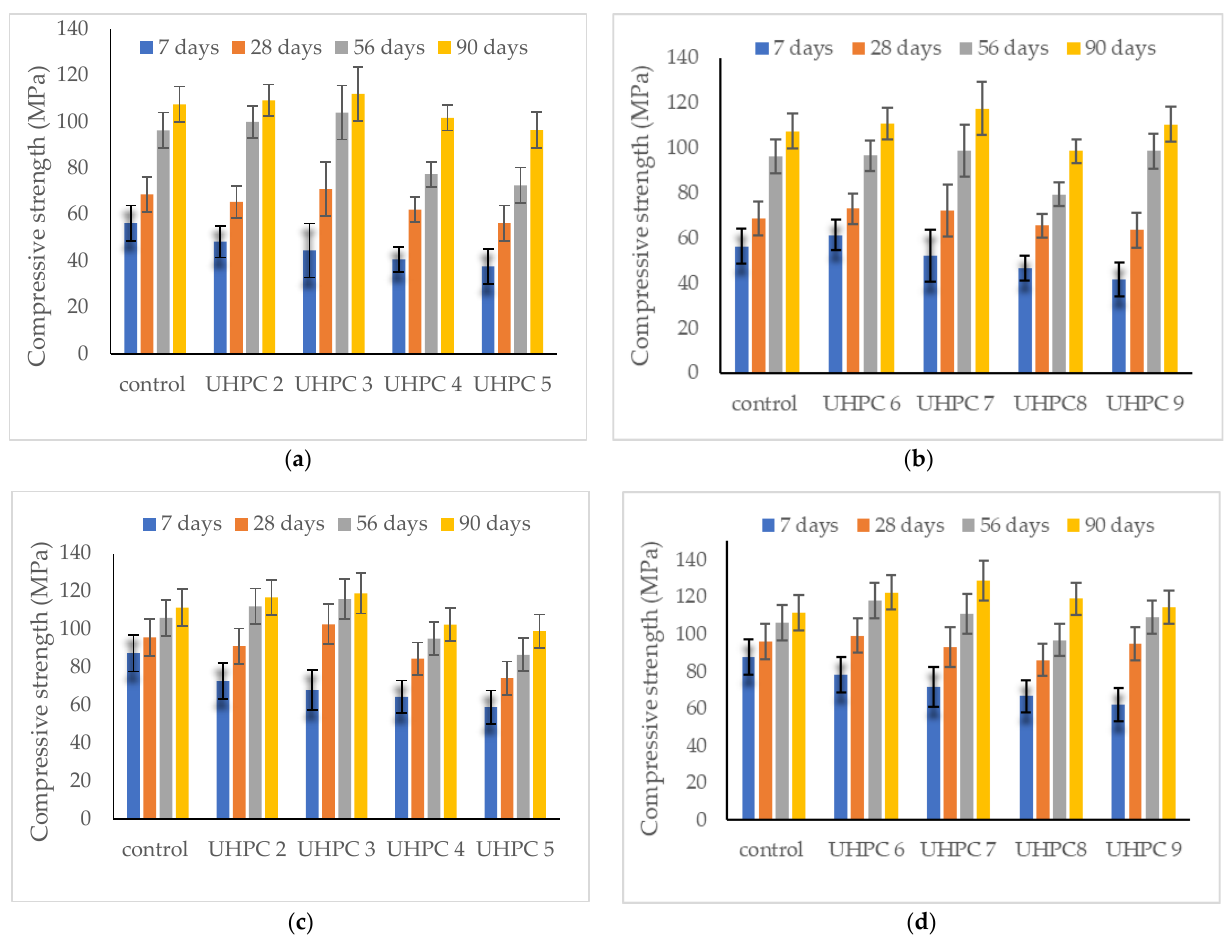
Figure 5. Compressive strengths of UHPC at 7,28,56, and 90 days.; ( a ) glass powder (N-curing), ( b ) lime powder (N-curing), ( c ) glass powder (H-curing), ( d ) lime powder (H-curing).